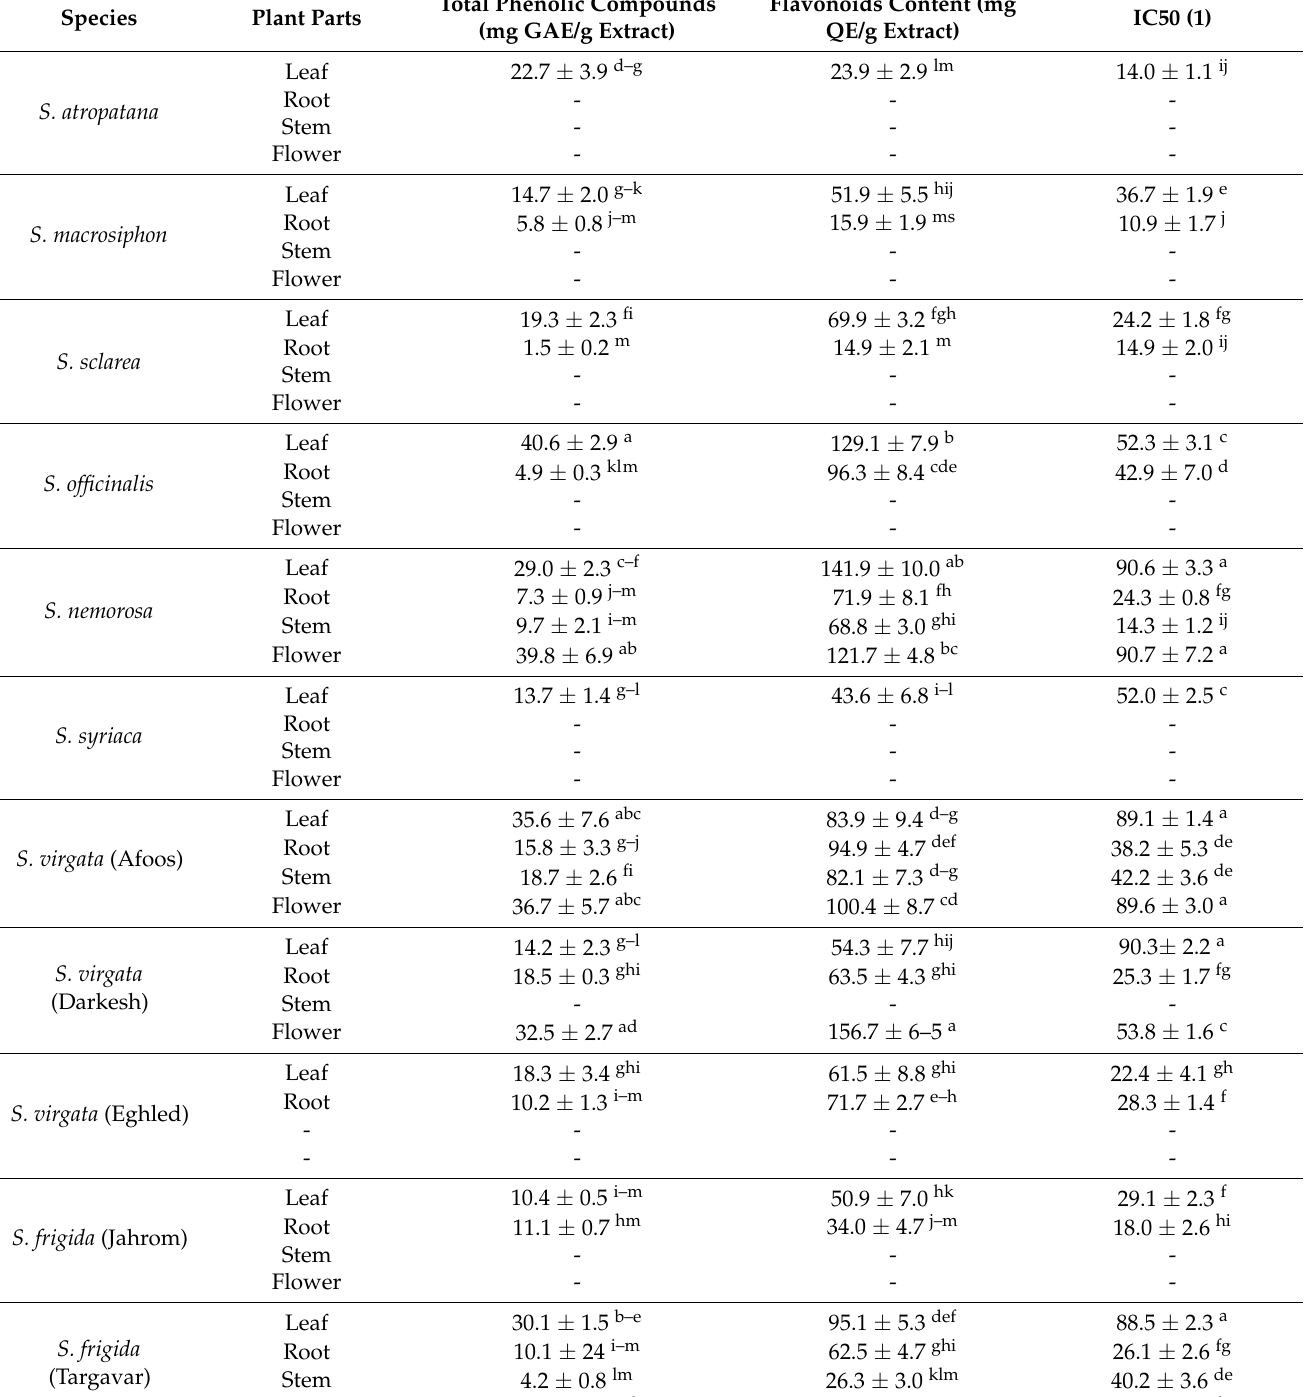
Table 2. DPPH assay and total phenolic compound and flavonoid content of various Salvia geno- types